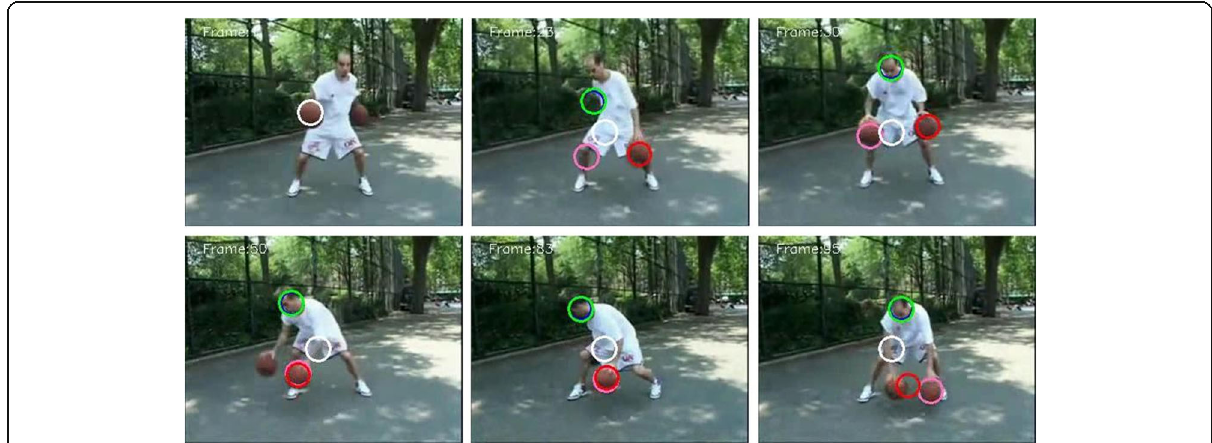
Fig. 28 The tracking failure example of video “ basketball_3 ” using CAM-Shift (white), PF (blue), VAPF (green), M-PF (pink), and the proposed tracker (red). Particle number N =